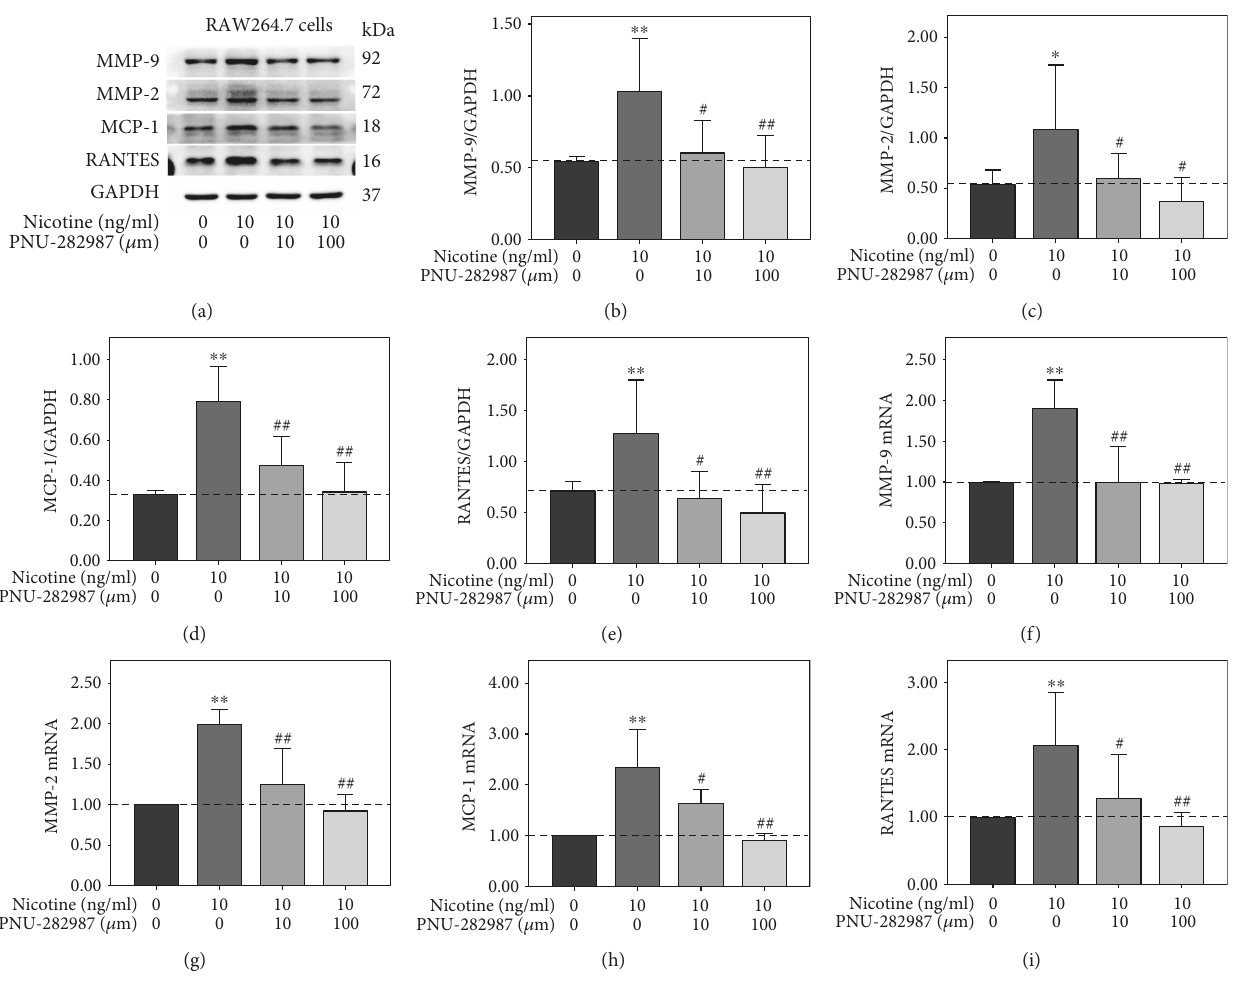
Figure 5: PNU-282987 abrogated nicotine-induced upregulation of matrix metalloproteinase- (MMP-) 9, MMP-2, monocyte chemotactic protein- (MCP-) 1, and regulated upon activation normal T cell expressed and secreted (RANTES) in RAW264.7 cells. (a) RAW264.7 cells were pretreated with 10 μ m PNU-282987 for 60 min prior to 10ng/ml nicotine exposure for 3 h. The band optical density values (means ± SD) of (b) MMP-9, (c) MMP-2, (d) MCP-1, and (e) RANTES in the Western blot were quanti fi ed by using ImageJ software and normalized to GAPDH. Representative results from three independent experiments are shown. (f) MMP-9, (g) MMP-2, (h) MCP-1, and (i) RANTES mRNA levels were examined by real-time reverse transcription polymerase chain reaction. All experiments were analyzed as triplicate independent experiments. ∗ p < 0 05 and ∗∗ p < 0 01 versus controls; # p < 0 05 and ## p < 0 01 versus the group treated with